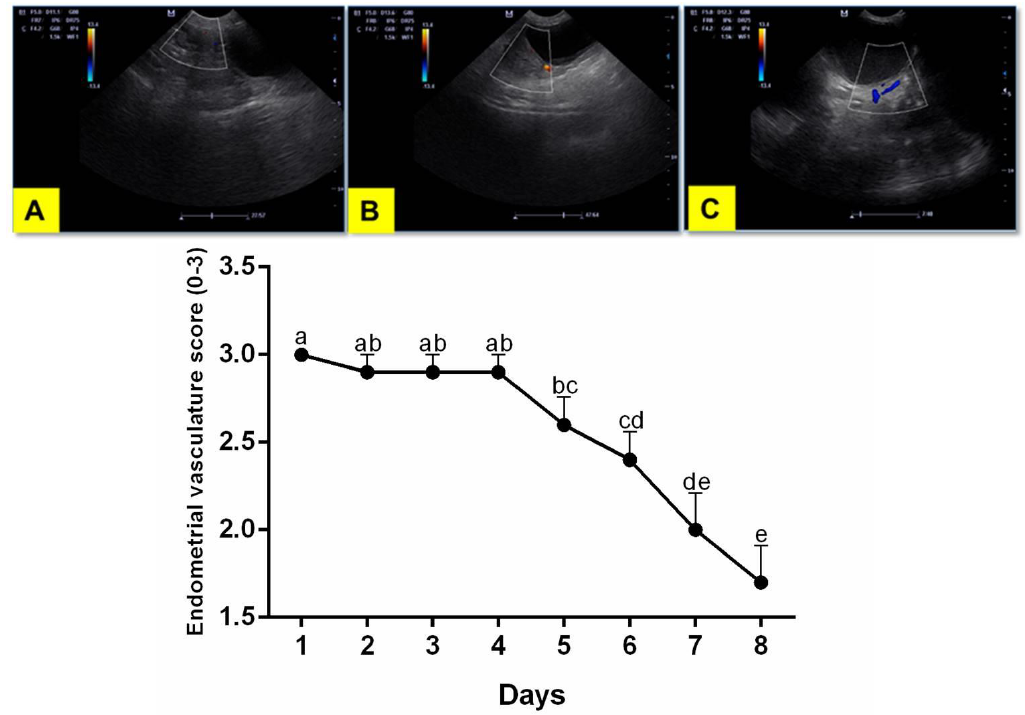
Figure 2. Endometrial vascularization score in cross-section Color Flow Doppler. ( A ) score 1 (minimum), ( B ) score 2 (intermediary) and ( C ) score 3 (maximum). (Below) Endometrial vascularization score (1–3) throughout the experimental period (1–8 days). a–e values with different letters differ significantly with time.